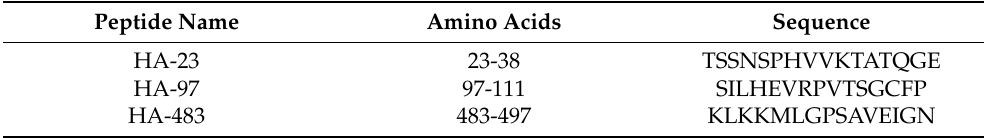
Table 1. Influenza B B/Brisbane/60/2008 HA peptide